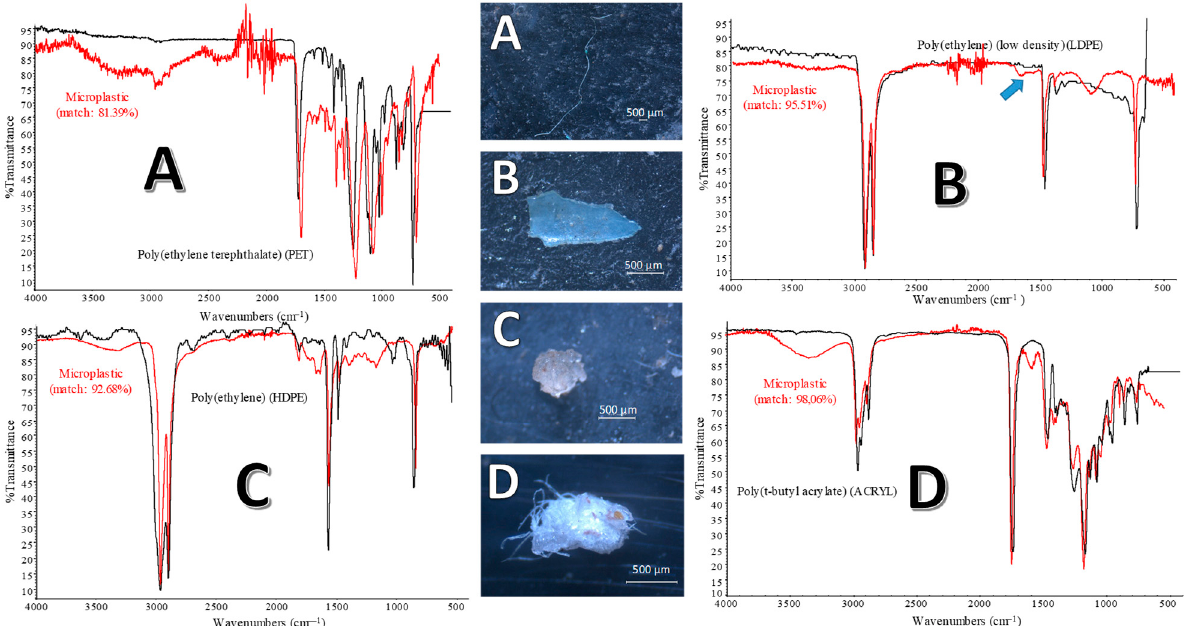
Figure 5. Infrared standard spectra (black) and microplastics (red) for: ( A ) Polyethylene terephthalate (PET) EFF 17 October 2019 (81.39%) (Sprouse Scientific Systems Polymers by ATR Library); ( B ) Poly(ethylene) (low density) INF 28 February 2019 (94.51% match) (Sprouse Scientific Systems Polymers by ATR Library); ( C ) Polyethylene INF 23 January 2020 (92.68% match) (Polymer Additives and Plasticizers). ( D ) Poly (t-butyl acrylate) EFF 19 December 2019 (98.06% match) (Sprouse Scientific Systems Polymers by ATR Library).